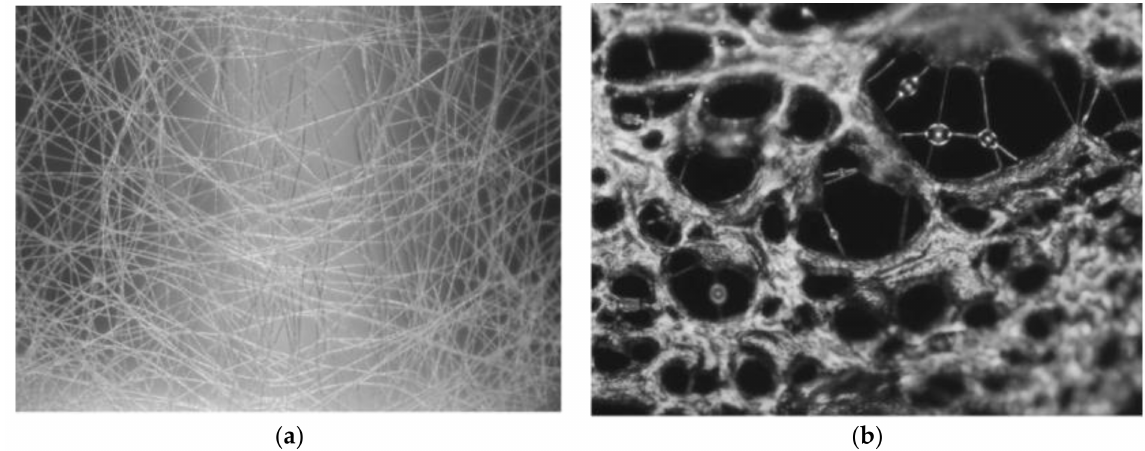
Figure 6. Optical microscope photographs of PVC nanofibrous polymer mats. ( a ) Clean filter, ( b ) Filter covered with deposited cigarette smoke